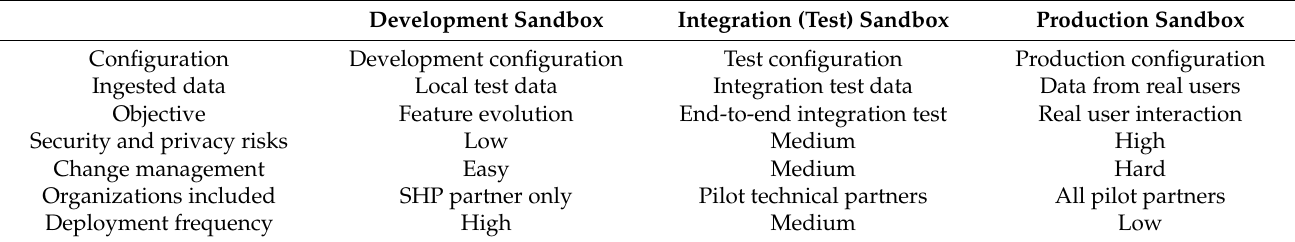
Table 3. SmartHabits deployment sandboxes